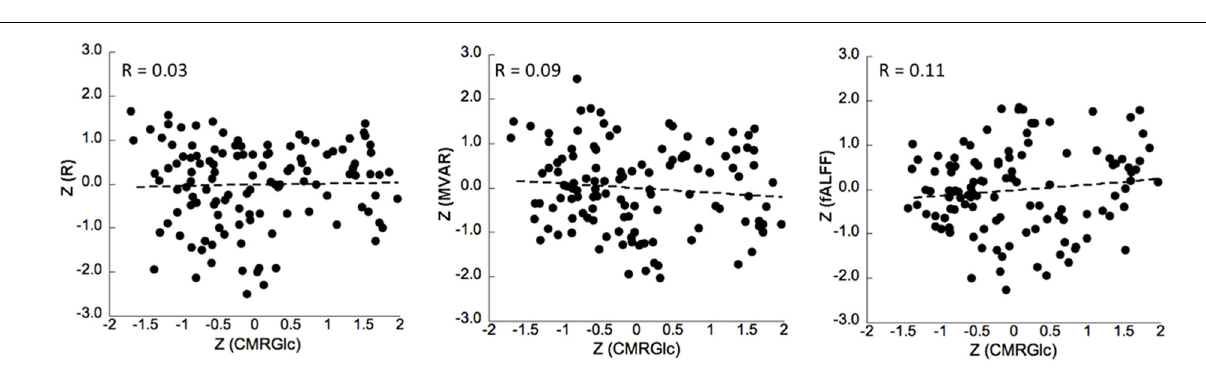
FIGURE 4 | Correlation between z-transformed CMRGlc values and z-transformed R (left), MVAR (middle) and fALFF (right) coefficients for all subjects in six networks at test and retest conditions. The R -value represents the Pearson’s correlation coefficient between the measures. R, bivariate-correlation coefficient; MVAR, Multi-Variate Auto-Regressive model coefficient; fALFF, fractional amplitude of low frequency